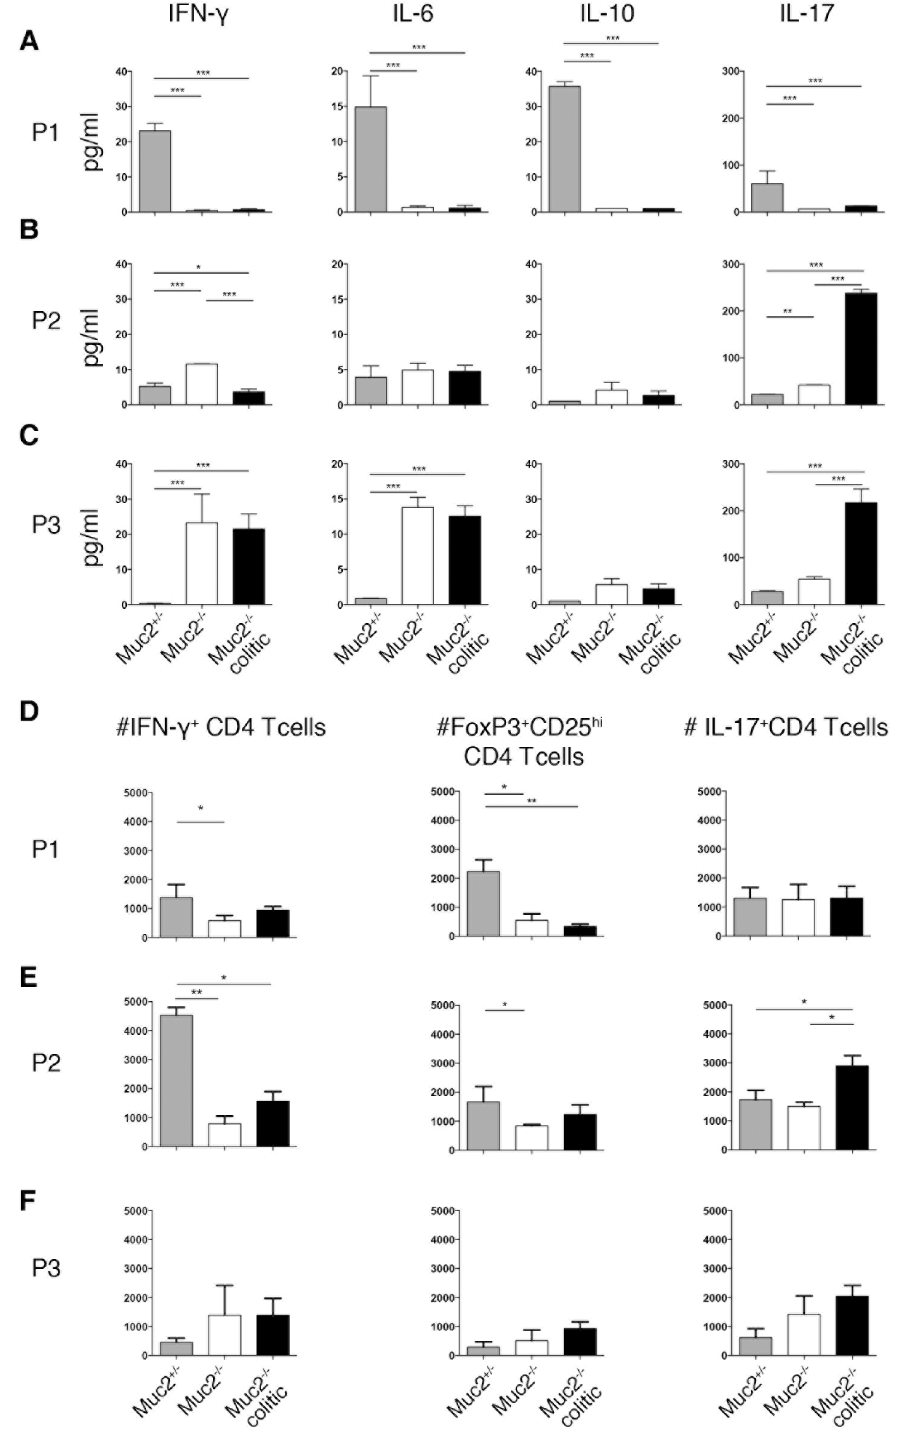
Fig 6. Colitis influences CD4 T cell differentiation induced by intestinal DC subsets. Cytokine concentrations in the supernatants of the T cell proliferation assays in Fig 5 were analyzed by Luminex and are shown in (A-C). (D-F) show the absolute number of differentiated CD4 T cells identified by staining for intracellular IFN- γ (left), CD25 and intracellular FoxP3 (middle) or intracellular IL-17A (right). Data are normalized to 10 4 CD4 T cells in co-cultures with the indicated DC subset after 5 days. Pooled data from